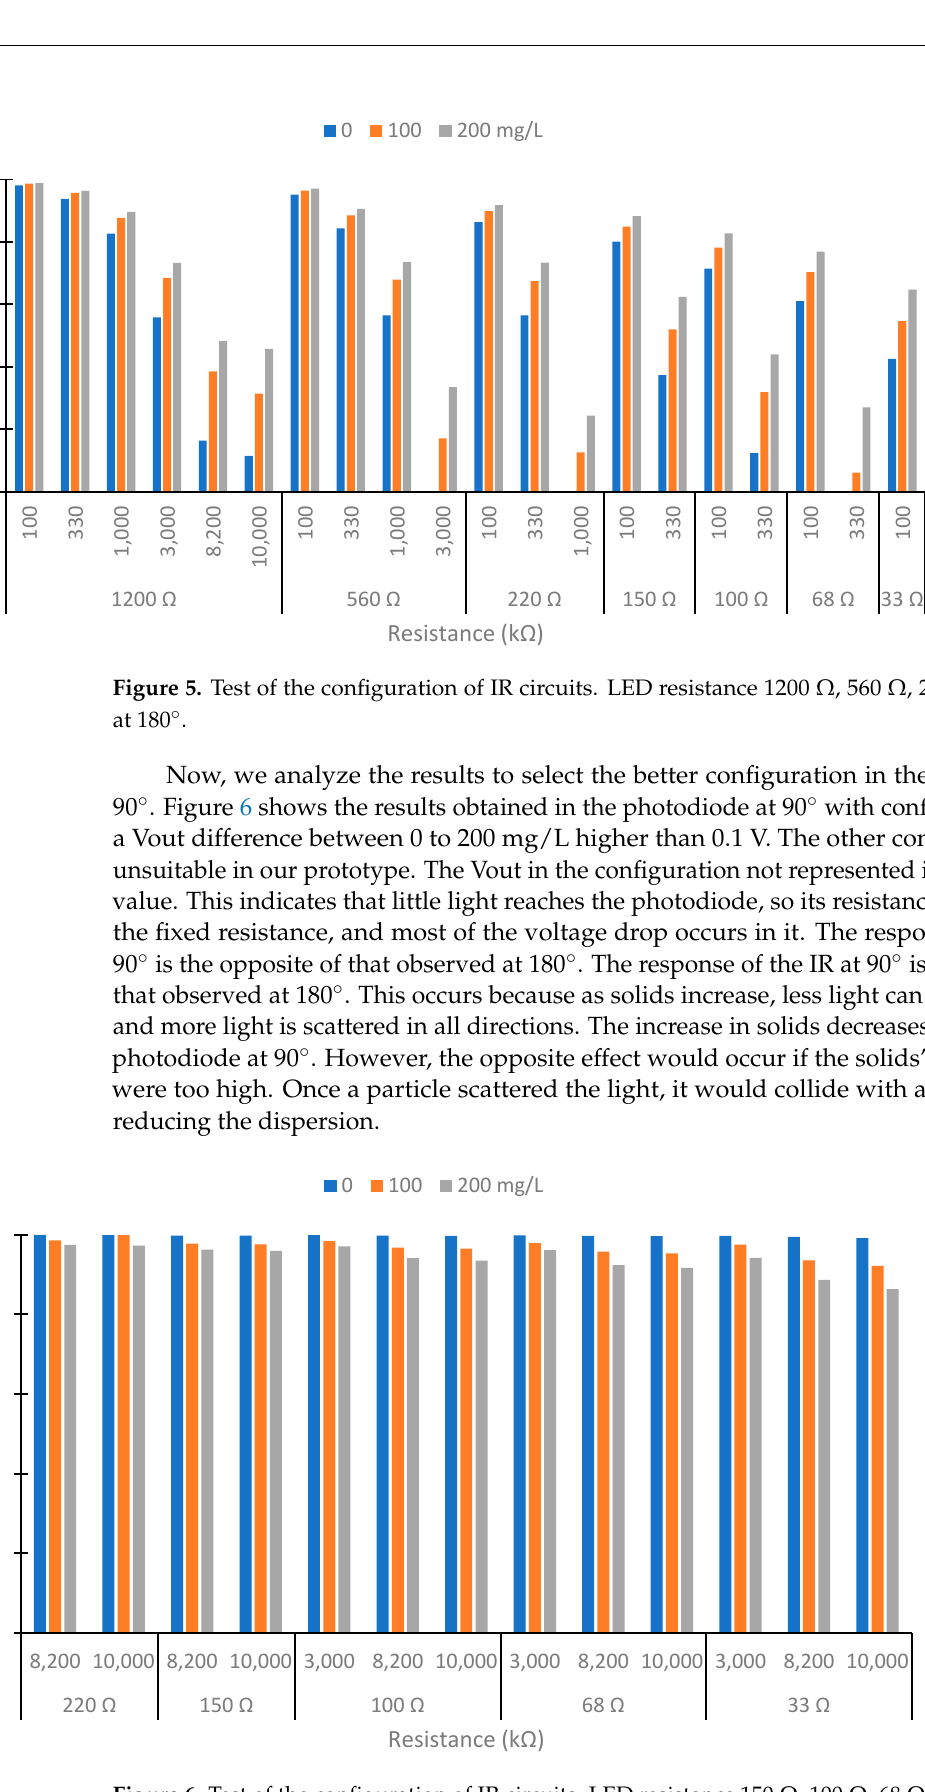
Figure 6. Test of the configuration of IR circuits. LED resistance 150 Ω , 100 Ω , 68 Ω , and 33 Ω at 90 ◦ Figure 6. Test of the con fi guration of IR circuits. LED resistance 150 Ω , 100 Ω , 68 Ω , and 33 Ω at 90°. The IR LED and voltage divider circuit con fi guration were selected. We determined the resistance values used in the voltage divider circuits of the LDRs at 90° and 180°. Table 2 represents the resistance values obtained, the fi xed resistance used, and the voltage. As expected, there existed a proportional relation between the resistance of the LDR and the solid concentration at 180°, which was inversely proportional at 90°. This was caused by the increase in solids, reducing the light that could cross the water but increasing the light sca tt ering. We observed that the resistance values were higher in the LDRs at 90° than 180°. However, the resistances of 90° were similar between them, as was the case with 180°. With the resistance values, we calculated the ideal resistance for each light with Equation (1). As in our prototype, we could not locate six di ff erent circuits; we needed to select two resistances (LDR at 180° and 90°). The selected resistances were 1.2 k Ω in the voltage divider at 180° and 33 k Ω at 90°. The di ff erence between the optimal and select resistance was minimal (0.011 V in the case with more di ff erence). If we observe the values of voltage di ff erence in the case of the voltage divider of the LDR at 180°, the di ff erences are less than 0.3 V. These di ff erences are lower in comparison to those obtained in the LDR at 90°. The di ff erences are similar to the blue and green light, with values near 0.674 V. Nevertheless, the di ff erence is 1.276 V for red light. The sediment causes the light used to be red and, therefore, will sca tt er more light of this color. Table 2. Selection of the be tt er resistance in the LDR voltage divider. Parameters